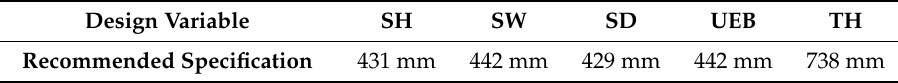
Table 2. Recommended specifications for the South Korean submarine